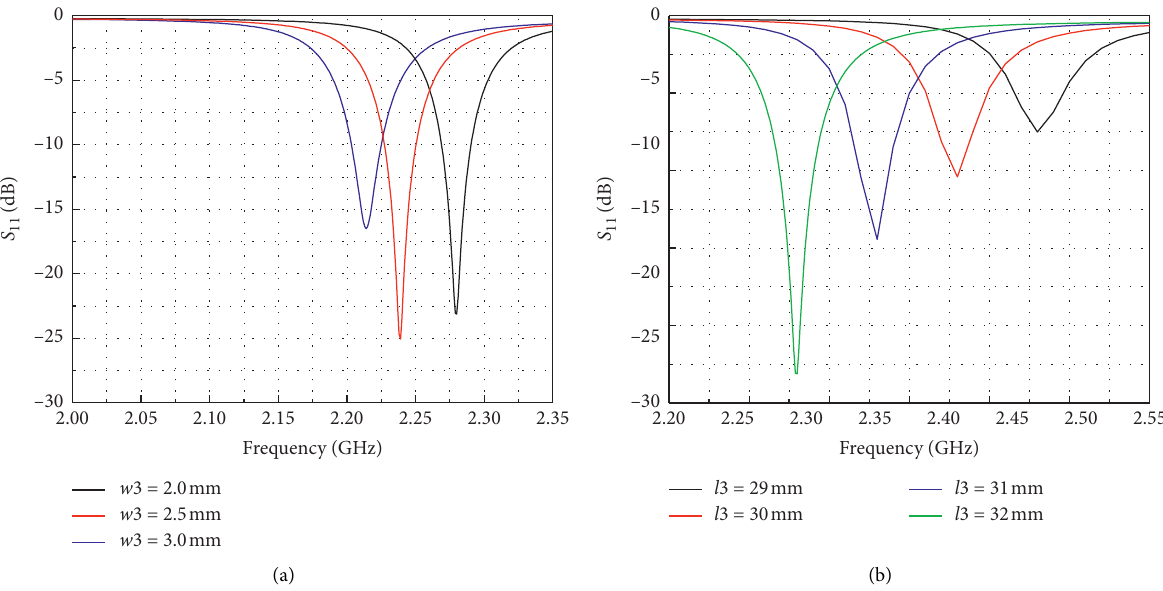
Figure 3: Resonant frequency of microchannels of different sizes: (a) width; (b) length.